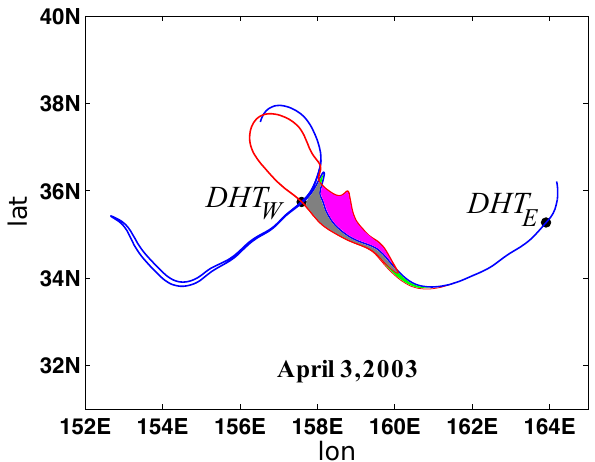
Fig. 23. Intersection of lobes governing transport across the western eddy and those governing transport across the main stream of the Kuroshio current.